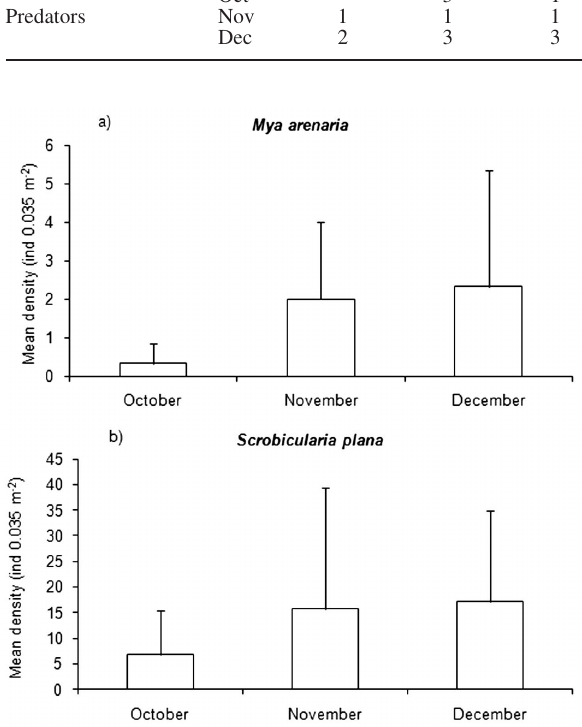
Fig . 4. – Mean density (and standard deviation) per plot (ind/0.035 m 2 ) of Mya arenaria juveniles (a) and Scrobicularia plana juveniles (b), over